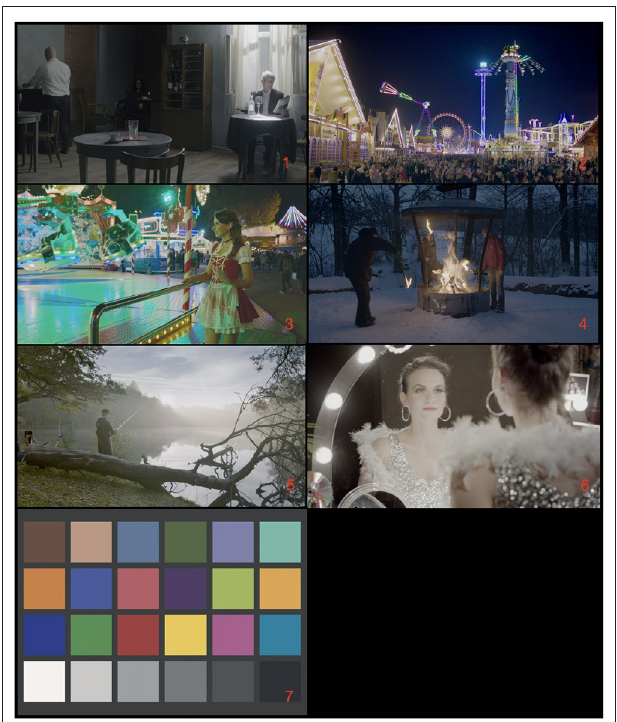
FIGURE 3 | Image contents including six images selected from the HdM dataset ( Froehlich et al., 2014) and one color-checker. The image index is labeled in the bottom-right corner.